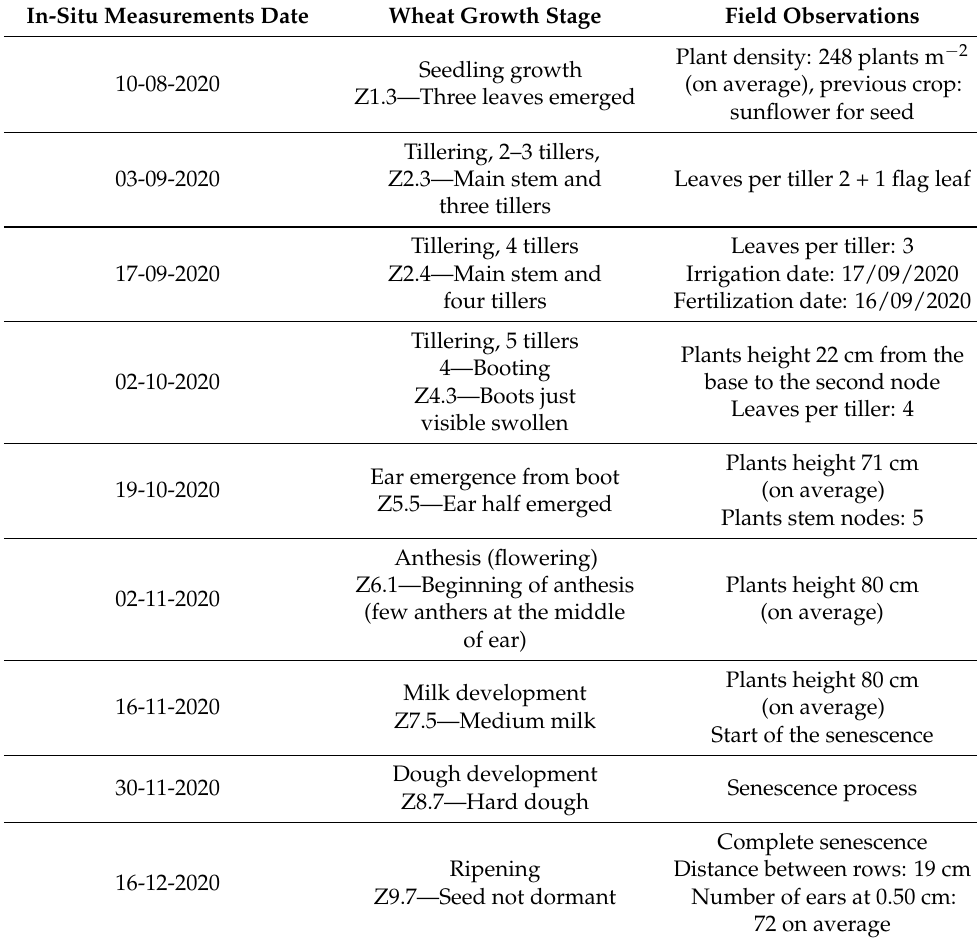
Table 4. Winter wheat field campaign observations with in-situ sampling dates, crop growth stages and details of the field